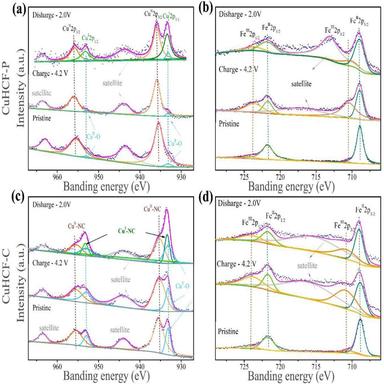
The XPS Cu 2p spectra of (a) CuHCF-P and (c) CuHCF-C, and the XPS Fe 2p spectra of (b) CuHCF-P and (d) CuHCF-C at different redox states including as-prepared samples. The electrodes charged to 4.2 V and discharged to 2.0 V.